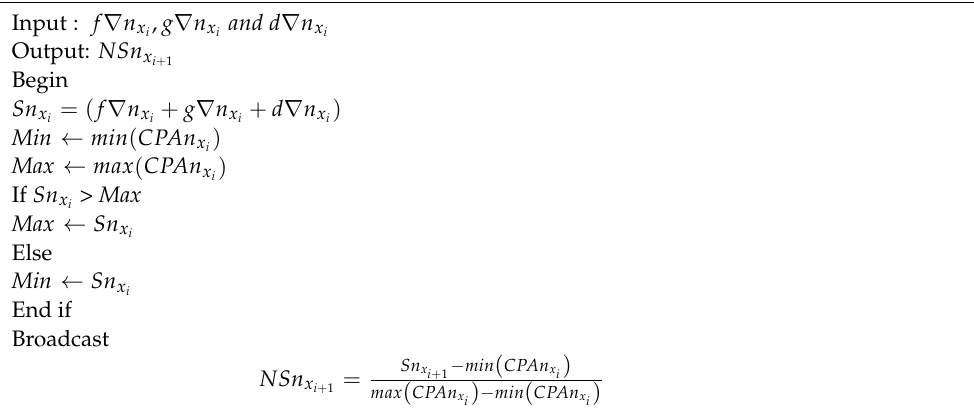
Algorithm 4 Nodes performance in